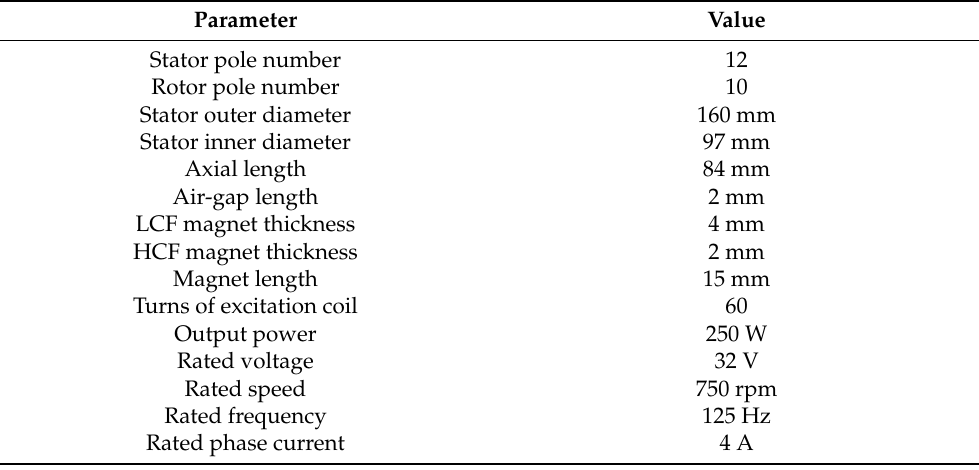
Figure 8. Saturation current versus stator and rotor tooth width. The main design specifications and parameters of the machine are listed in Table 2. Table 2. Main design specifications and parameters of the prototype.